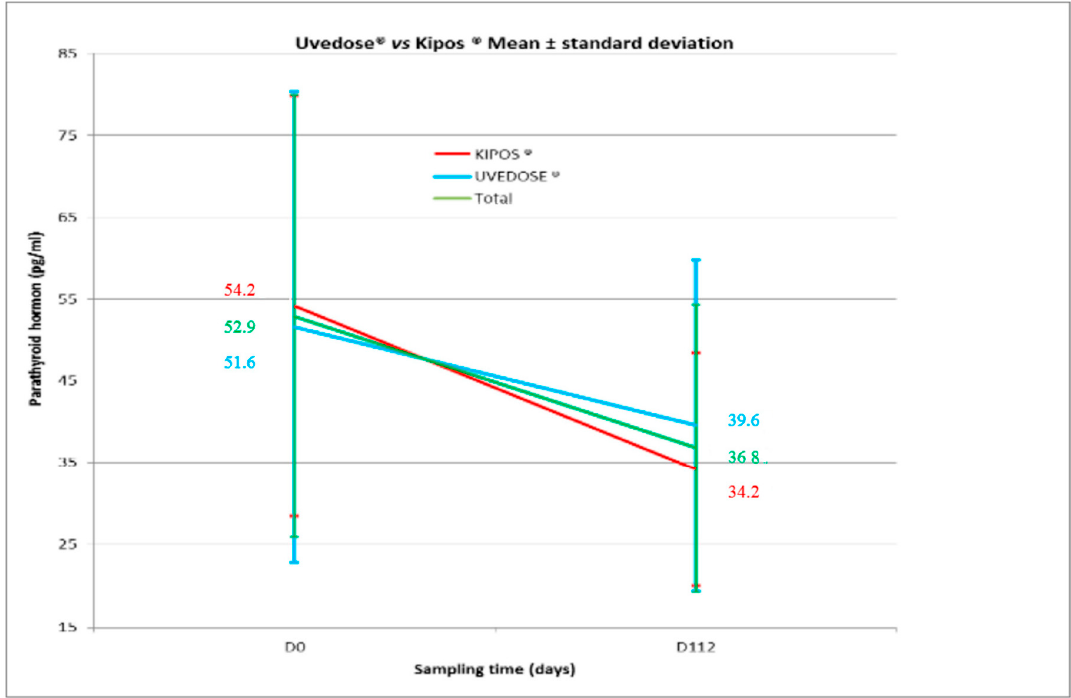
Figure 2. Serum PTH levels after administration of a single dose of 100,000 UI of vitamin D3. Serum calcium concentration was stable over time and remained the same on Day 45, Day 90 and Day 112 in both groups (2.3 mmol/L) with no statistical difference between groups ( p = 0.481, p = 0.660 and p = 0.323,